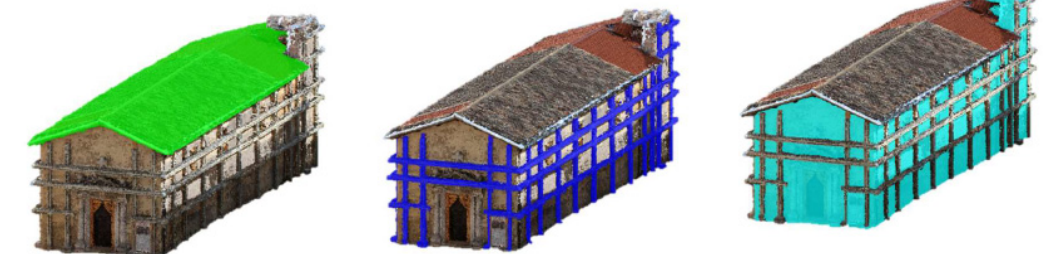
Figure 3. Regions of point cloud segmentation (roof, security elements and walls).